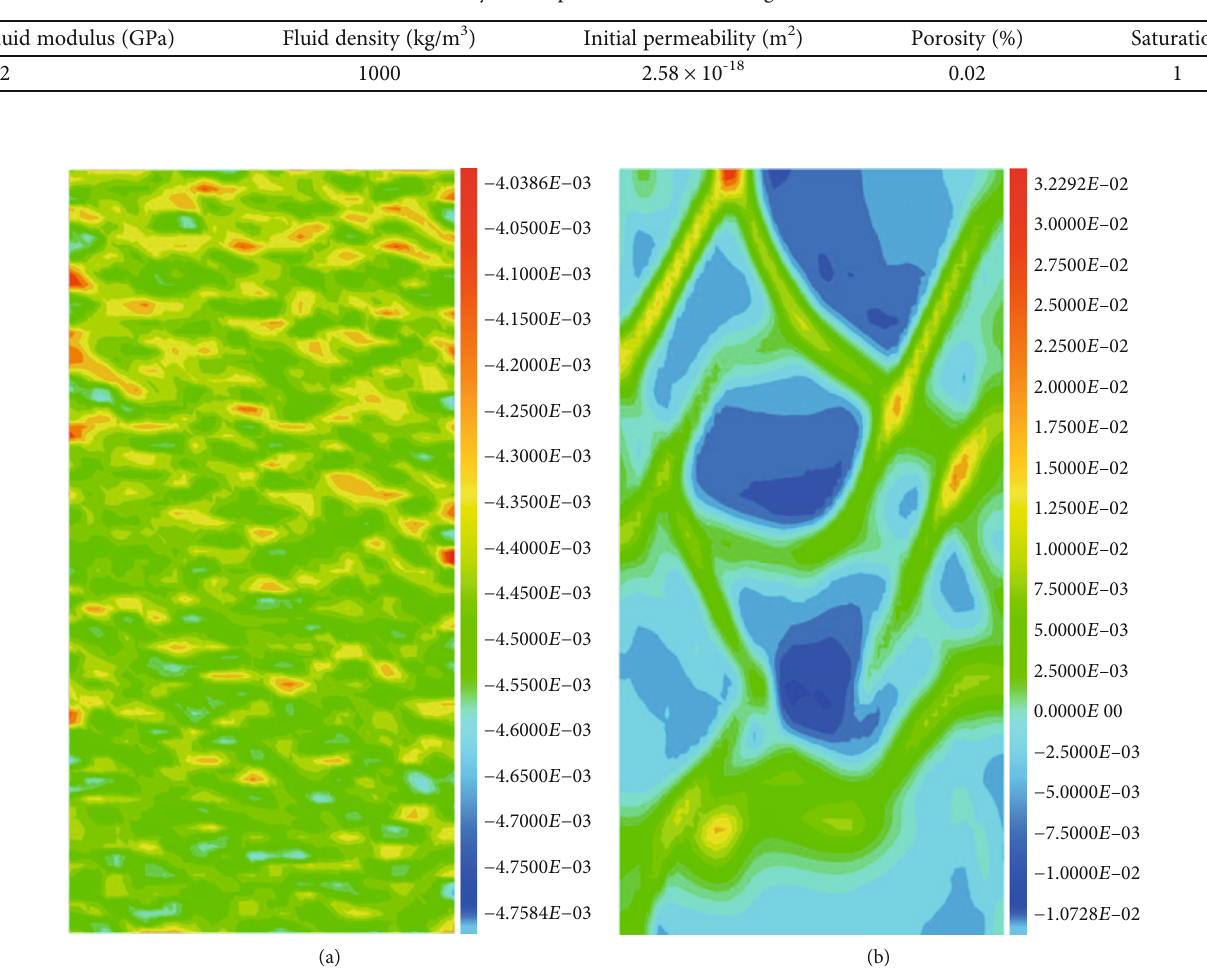
Table 5: Hydraulic parameters of Beishan granite.